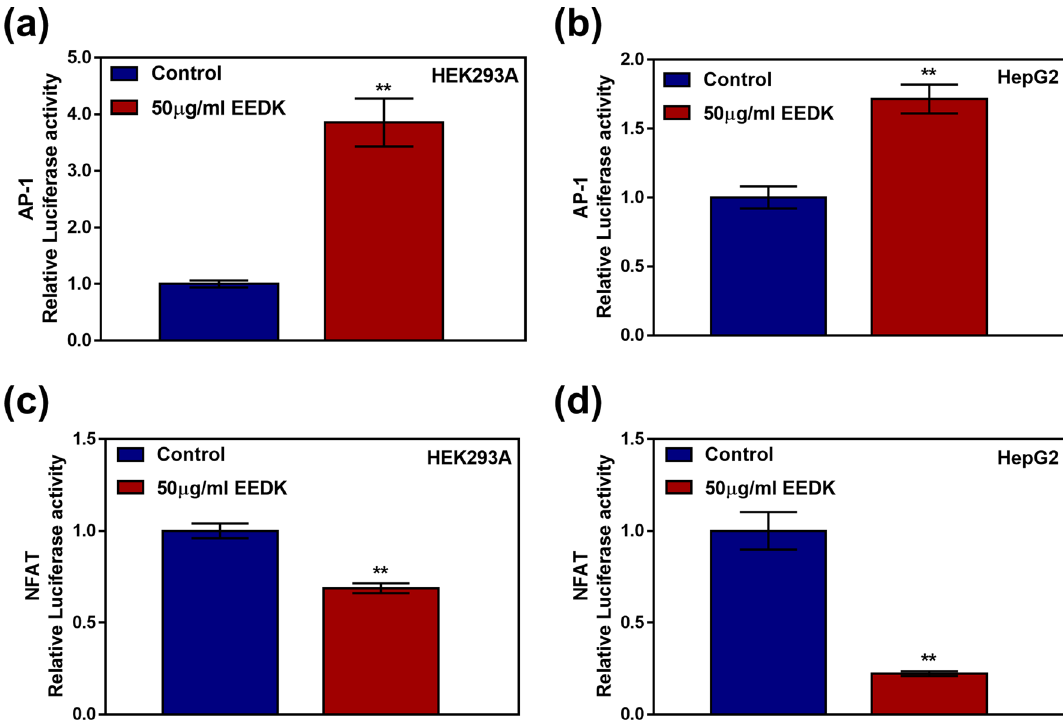
Figure 6. The effects of EEDK on the DNA binding activity of AP-1 and NFAT. ( a , b ) AP-1 activity of ( a ) HEK293A and ( b ) HepG2 cells exposed to the control (0.5% (v/v) DMSO) and EEDK (50 μg/mL) for 24 h. Cells were transfected with 3xAP1pGL3 (40342, Addgene). ( c , d ) NFAT activity of ( c ) HEK293A and ( d ) HepG2 cells exposed to the control (0.5% (v/v) DMSO) and EEDK (50 μg/mL) for 24 h. Cells were transfected with